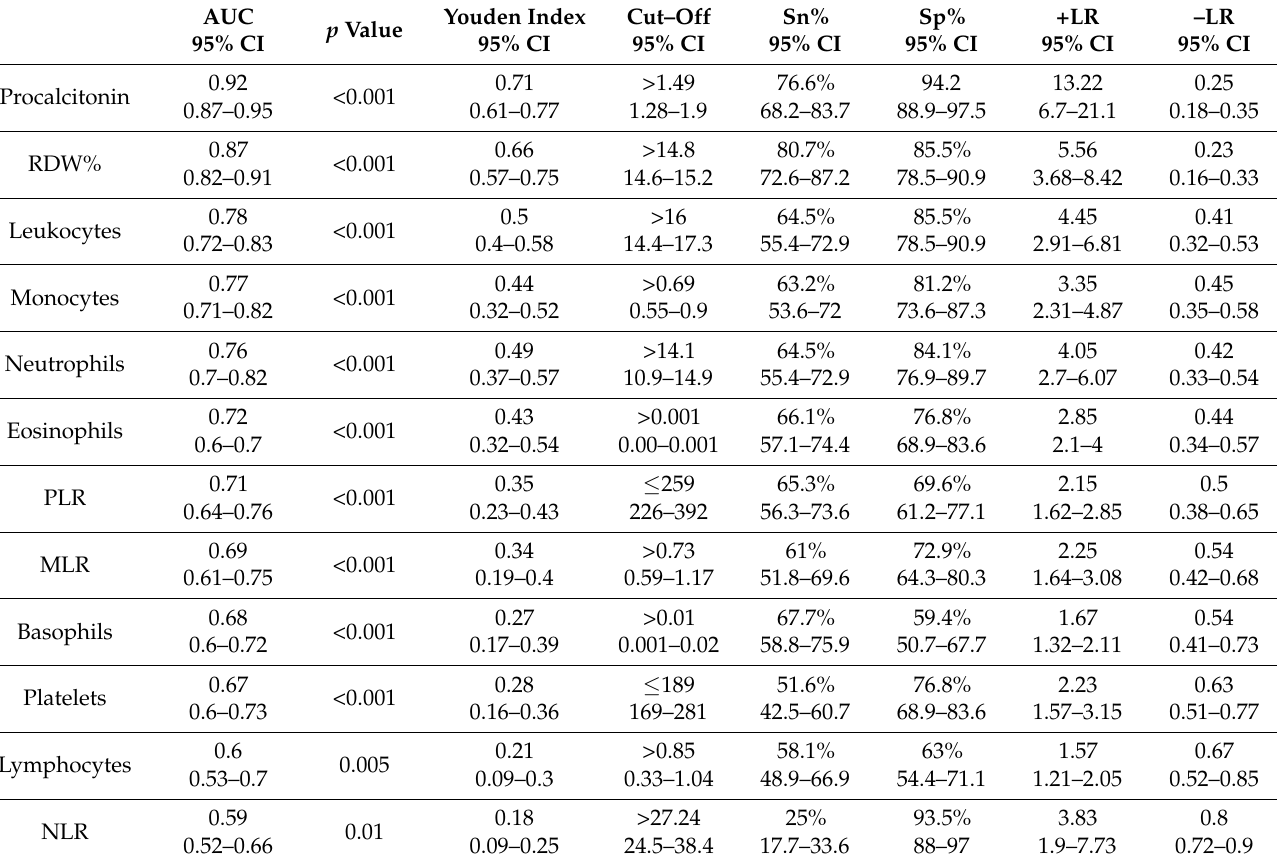
Table 2. Discriminative Analysis Between Bacterial and Viral